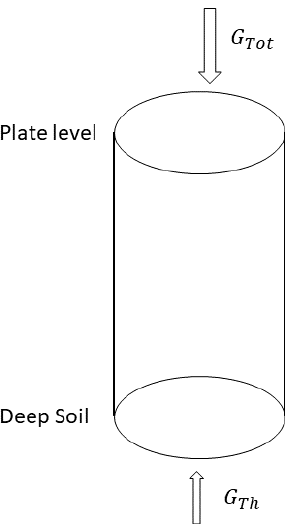
Figure A1. Soil colon between the soil surface and a deep soil level where the soil temperature does not change during the